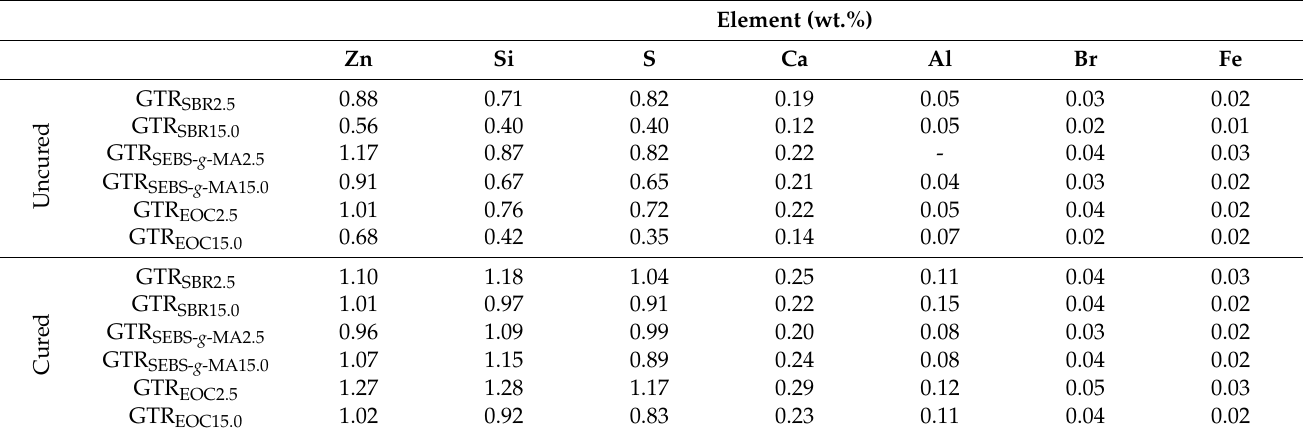
Table 6. XFR measurement results for studied materials.